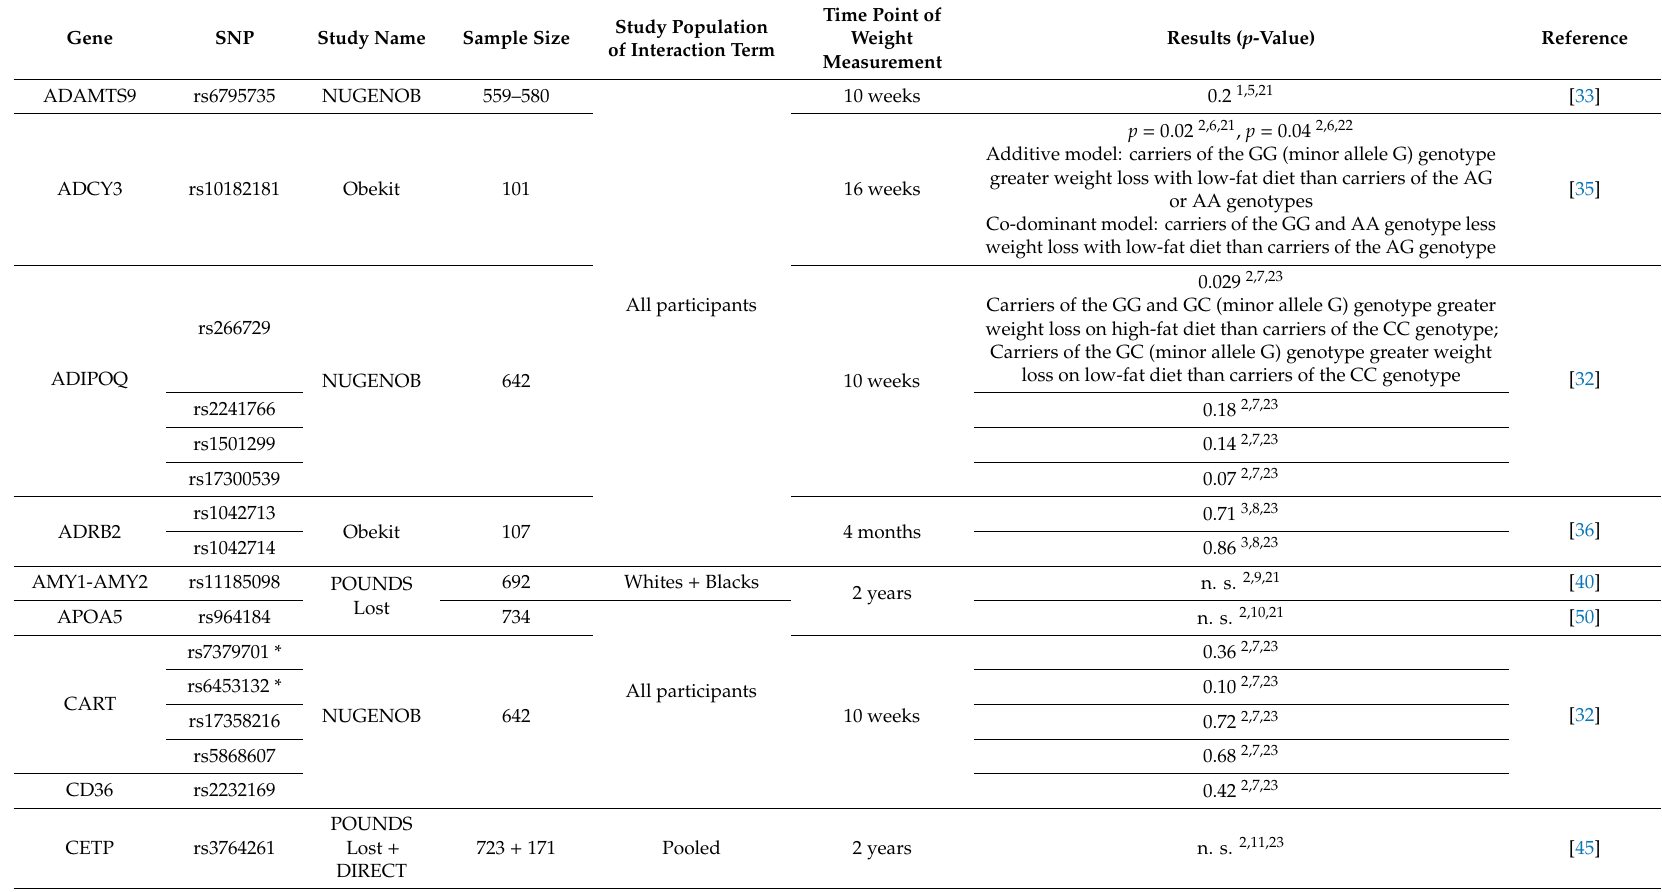
Table 2. Interaction of genotype and fat intake on weight